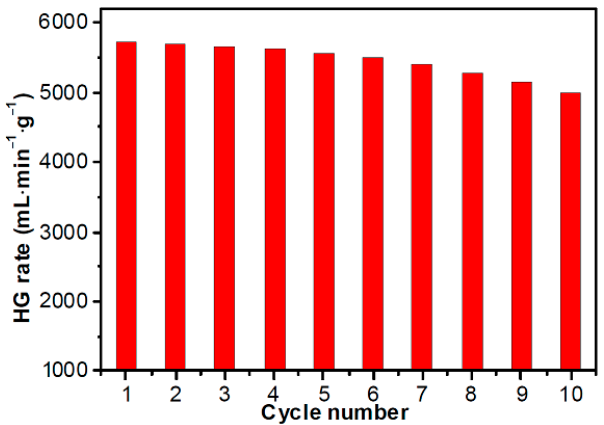
Figure 13. Multicycle performance of Co–B catalyst prepared in acetone for the hydrolysis of 1.5 wt % NaBH 4 at 298 K.